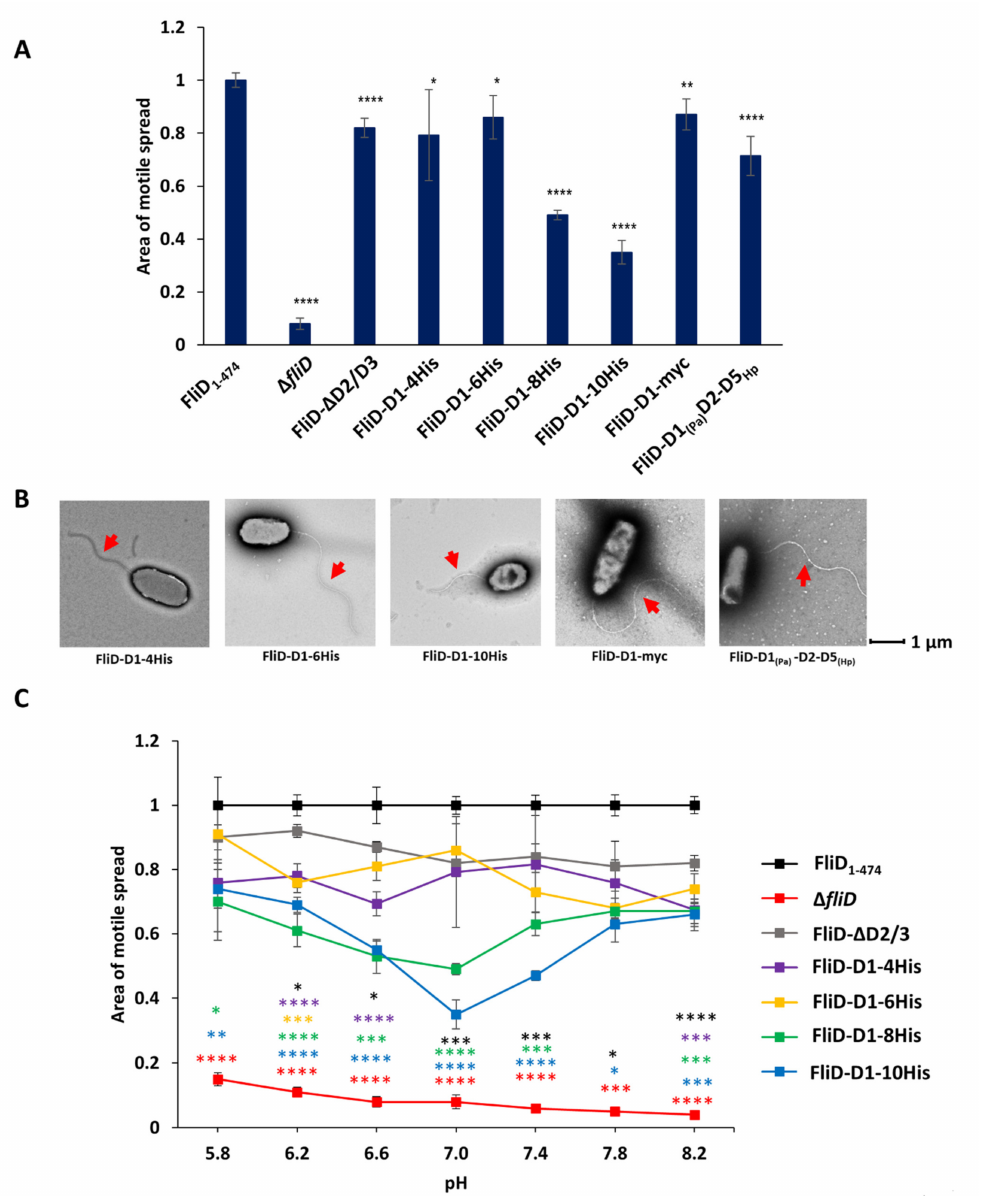
Figure 5. Effects of head/plate domains replacement in flagellar formation and function. Swimming motility analysis ( A ) and negative-stain EM images ( B ) of knockout and complemented P. aeruginosa PAO1 strains. Head/plate domains were replaced by a peptide tag or equivalent domains from Helicobacter pylori . ( C ) The effect of pH on motile spread of PAO1 strains complemented by fliD - ∆ D2/3 containing polyhistidine tags of different length. Area of motile spread for each strain is normalized to that of the full-length wild type complemented strain [ Pa ∆ fliD / fliD Pa (1-474)]. Motile spread of different strains compared to that of FliD- ∆ D2/3 strain. (* p < 0.05; ** p < 0.01; *** p < 0.001 **** p <